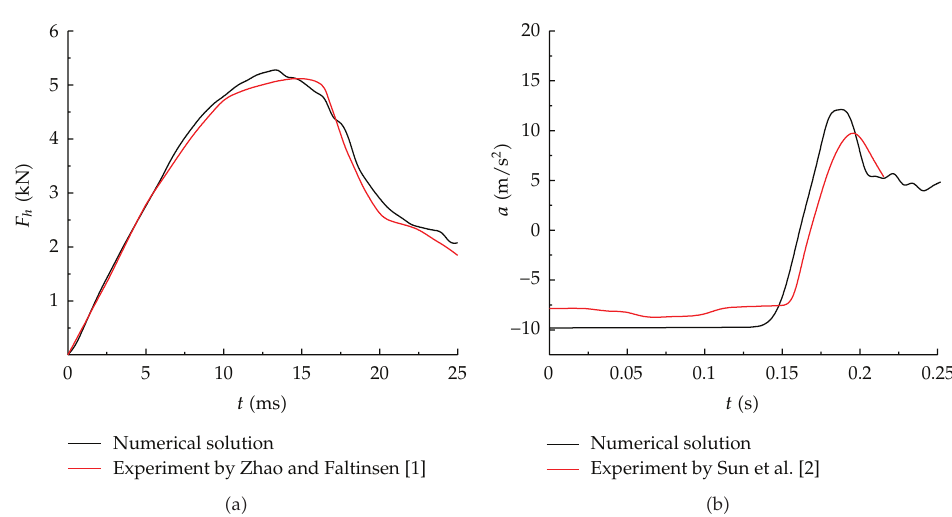
Figure 2: Comparison between numerical solutions of hydrodynamic (cid:2) a (cid:3) ; wedge acceleration (cid:2) b (cid:3) and experiment data of Zhao and Faltinsen (cid:5) 1 (cid:6) and Sun et al. (cid:5) 2 (cid:6)